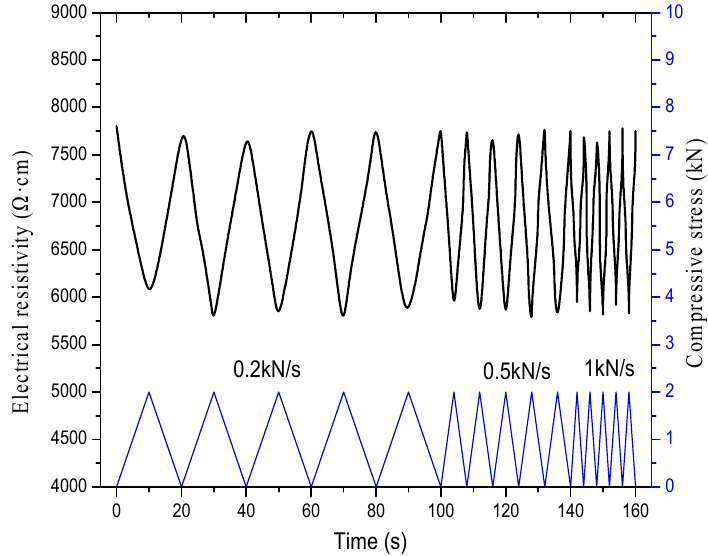
Figure 19. Relationship of electrical resistivity and compressive stress of specimens incorporating 2% content of graphene under different loading rate after freeze–thaw.